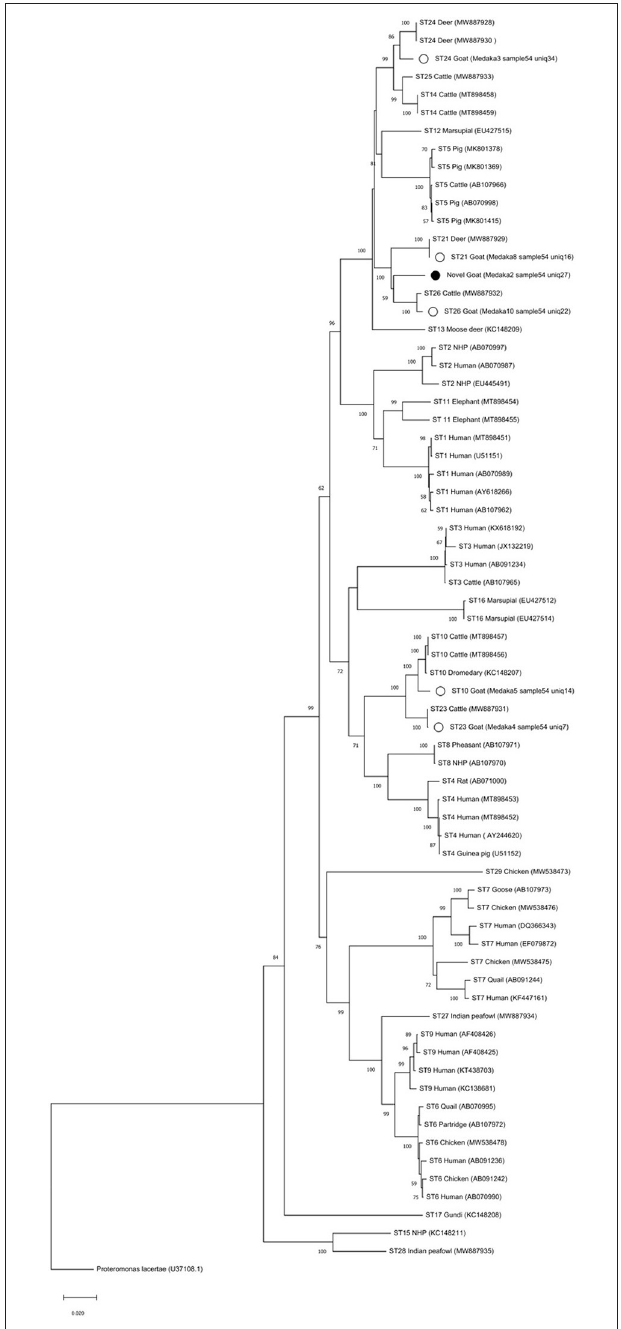
FIGURE 2 | Phylogenetic reconstruction with MinION sequences. The full-length SSU rRNA gene nucleotide sequences obtained in this study were aligned with Blastocystis reference nucleotide sequences (accession numbers in parenthesis). Nucleotide sequences were aligned with the Clustal W algorithm and phylogenetic analysis was performed using the Neighbor-Joining (NJ) method and genetic distances calculated with the Kimura 2-parameter model using MEGA X (48, 49). Bootstrapping with 1,000 replicates was used to support the clades. The bootstrap number is shown on each node. Proteromonas lacertae was used as an outgroup. White circles show the samples with full-length obtained in this study and the black circle is showing the novel subtype found, called